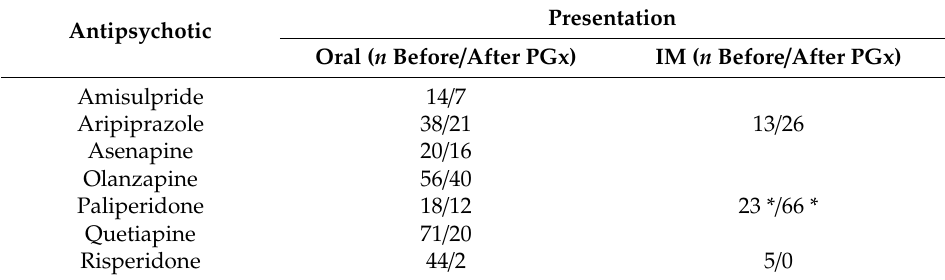
Table 2. Antipsychotics prescriptions before / after PGx